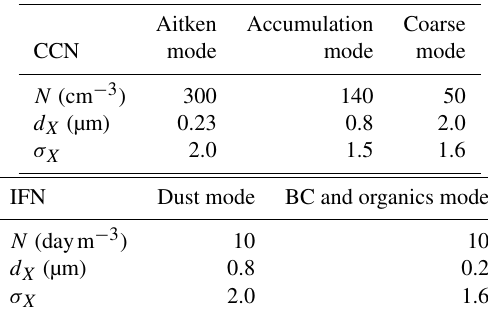
Table 1. Background CCN and IFN configuration for the STERAO idealized case simulations.